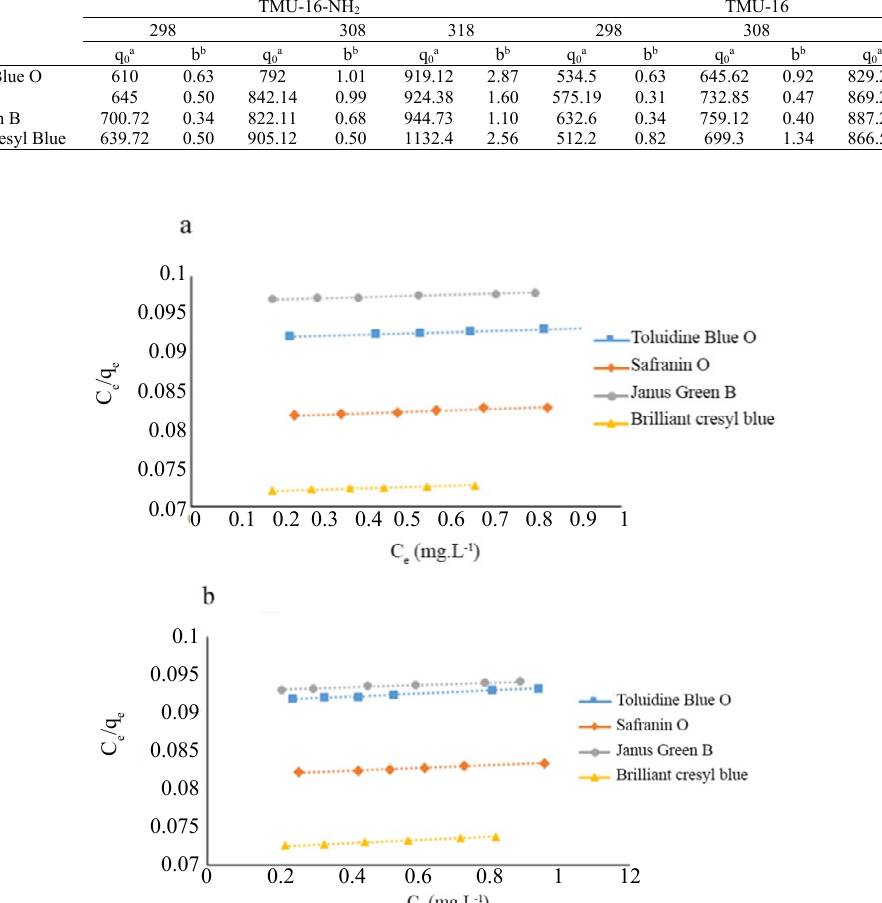
Fig. 3 . Linear plot of the Langmuir equilibrium model of adsorption dyes over (a) TMU-16-NH and (b) TMU-16. 2